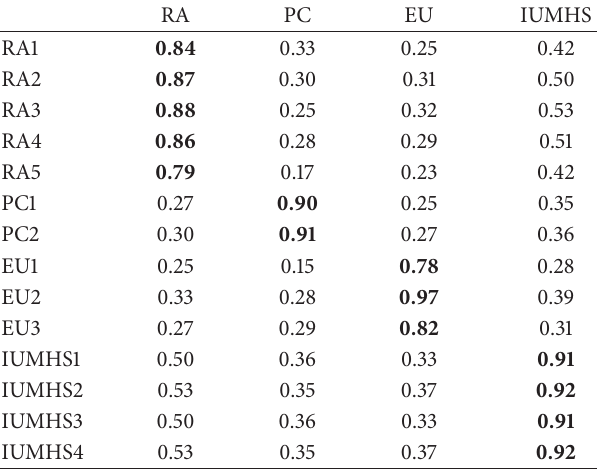
Table 4: The item-to-construct